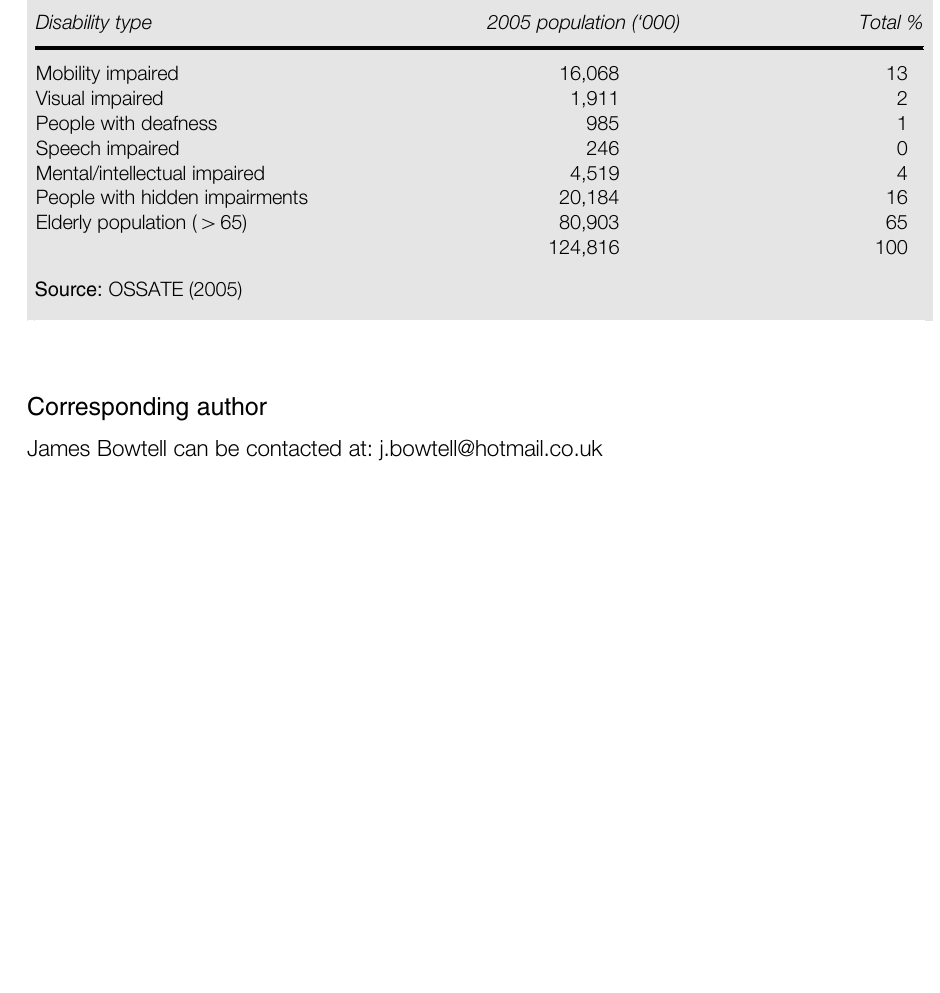
Table AII Breakdown of the disabled population by disability